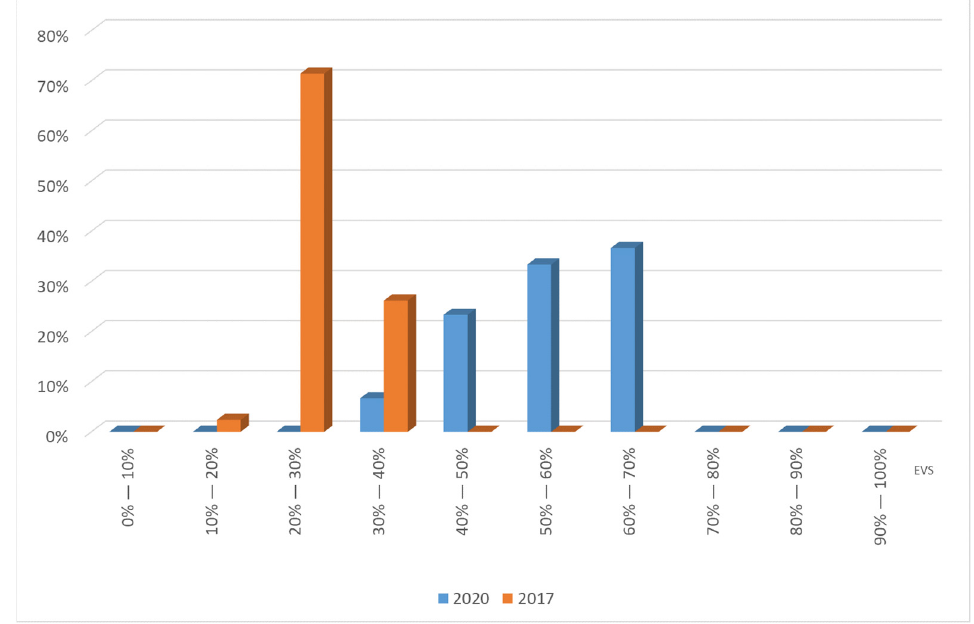
Figure 11. Frequency distribution of the EVS values.